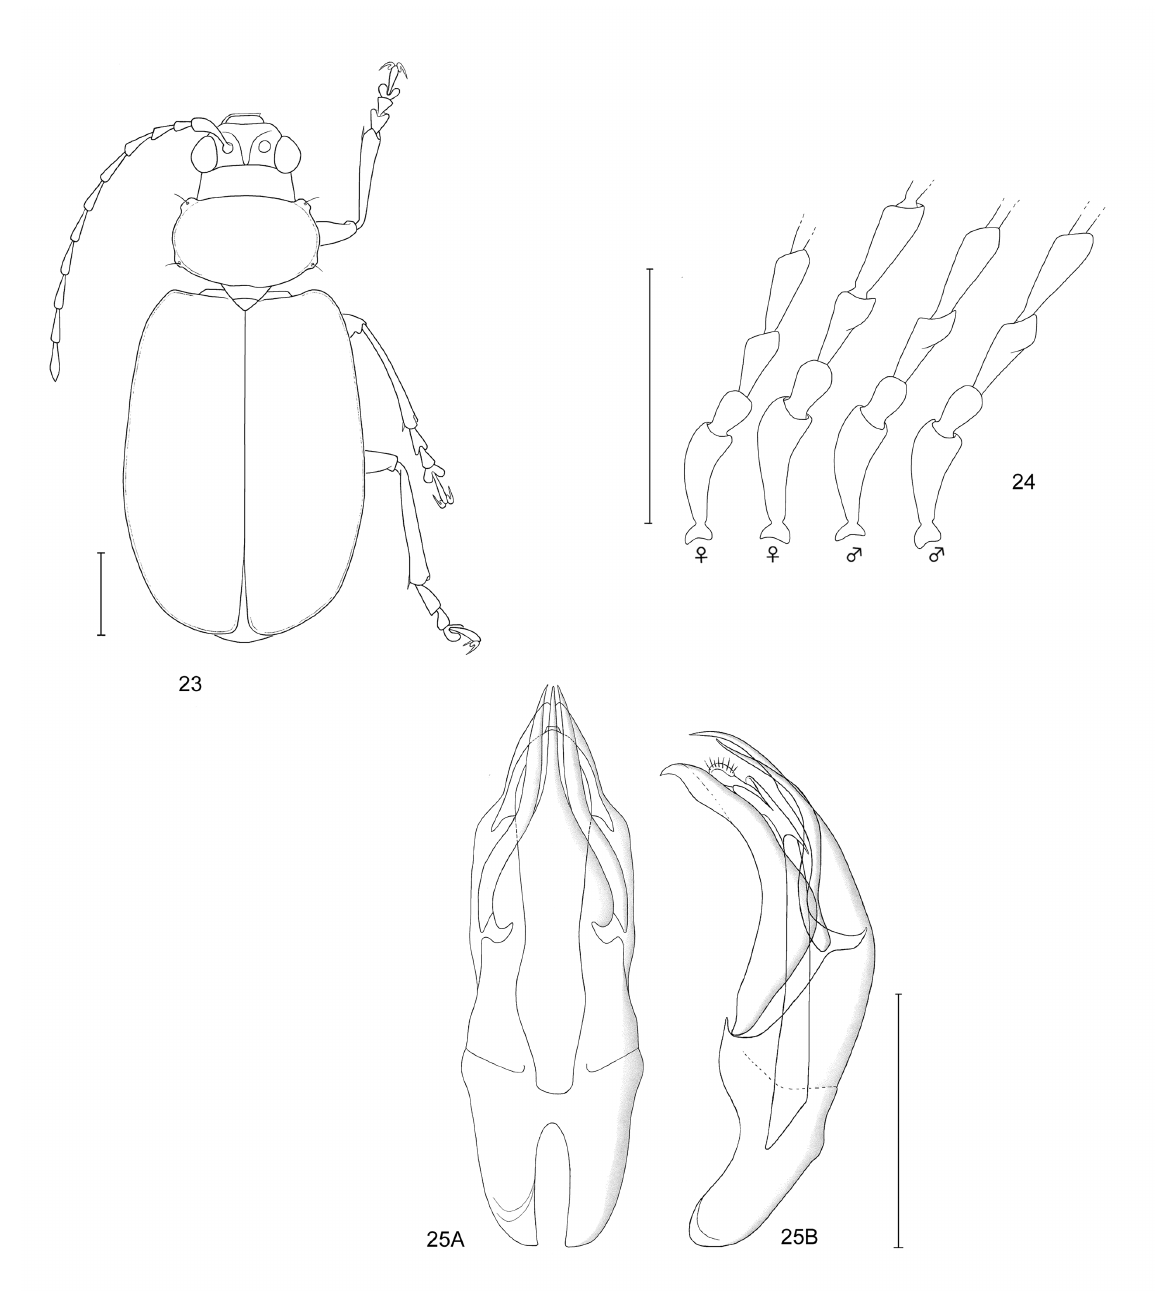
Figs 23-25. Oosagitta thomasi sp. nov. 23 . Habitus, semi-schematic dorsal view. 24 . Basal four antennomeres of 2 ♂♂ and 2 ♀♀. 25 . Median lobe. A . Dorsal. B . Lateral. Scale bars: 1